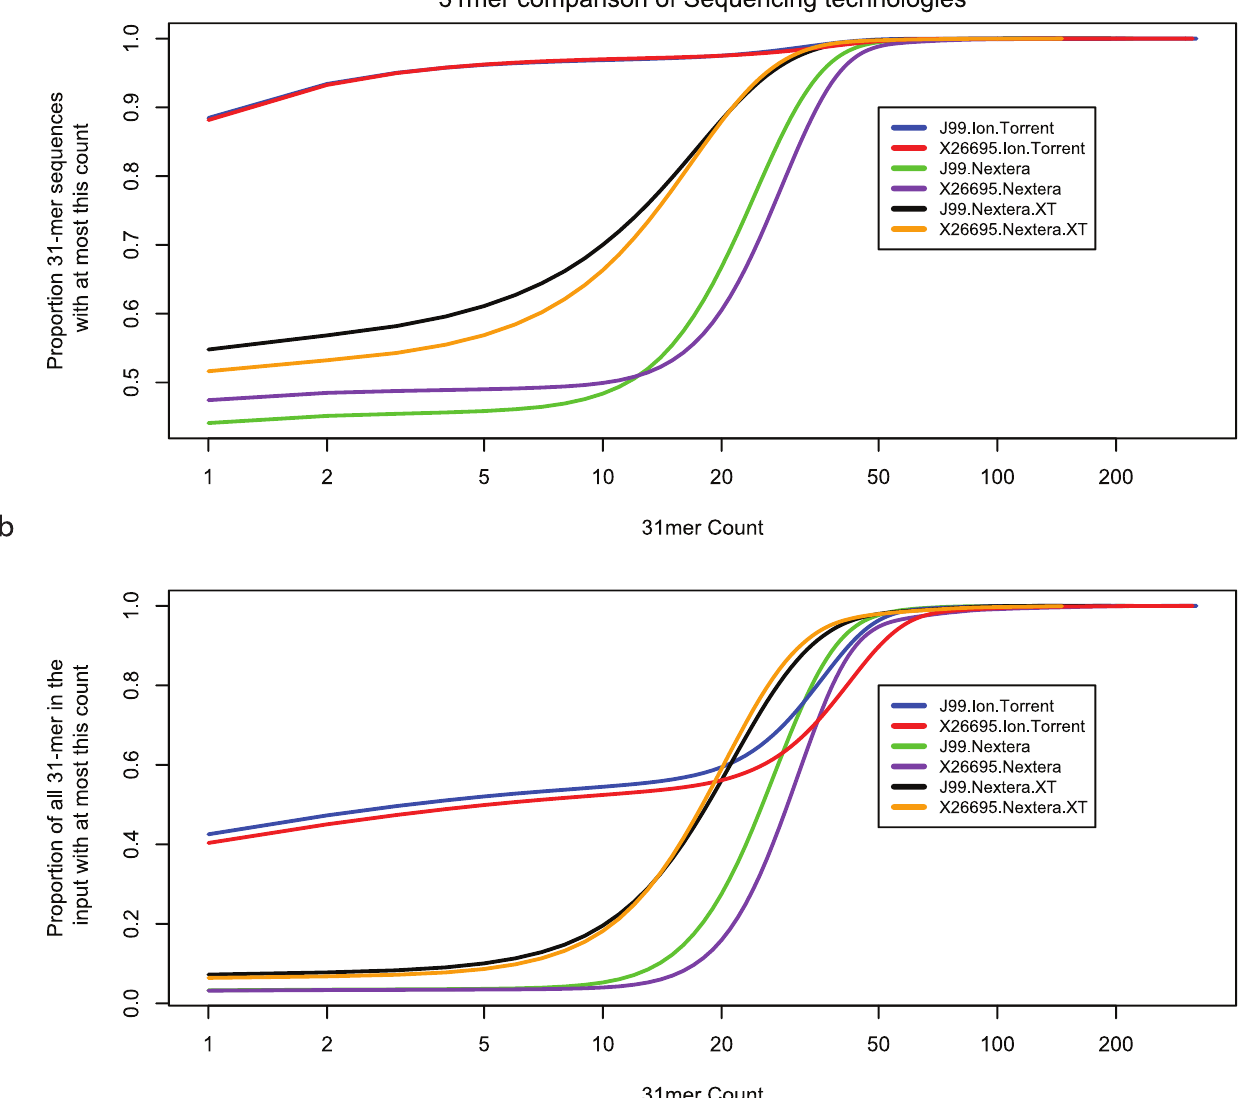
Figure 3. 31-mer quality control. Cumulative Proportion of 31-mers with respect to increasing frequency. (a) The cumulative fraction of 31-mers with at most this count. Each 31-mer is treated as a mathematical set and will be listed once. (b) Cumulative fraction of 31-mers with at most this count, ie a 31-mer occurring 5 times will be in the dataset 5 times. doi:10.1371/journal.pone.0067539.g003 respect to the expected coverage for both J99 and 26695 (Figure 2). The theoretical depth is enough for us to expect that all correctly sequenced 31-mers should occur multiple times in the data output, therefore, we plotted the fraction of all 31-mer sequences with respect to the count (Figure 3a). Despite the greater theoretical depth, the Ion Torrent data output has an extremely high proportion of unique 31-mers (J99, 0.8846; 26695, 0.8816) when compared to the Illumina MiSeq Nextera (J99, 0.4410; 26695, 0.4743) and Nextera XT (J99, 0.5479; 26695, 0.5163) indicating that there is an inherently higher error rate. We also analysed the fraction of 31-mers in the input with at most this count, ie a 31- mer with count of 20 will be listed 20 times (Figure 3b). Table 2). The GC content of the Ion Torrent mapped unique reads was significantly higher for both genomes, suggesting a